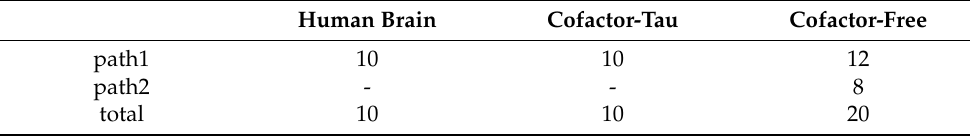
Figure 4. Changes of the pulling force over the reaction coordinate and the representative confor- mation of each stage. ( A ) human brain system; ( B ) cofactor-tau system; ( C ) cofactor-free system for path1; ( D ) cofactor-free system for path2. Table 1. Dissociation path statistics of the boundary chains of the three